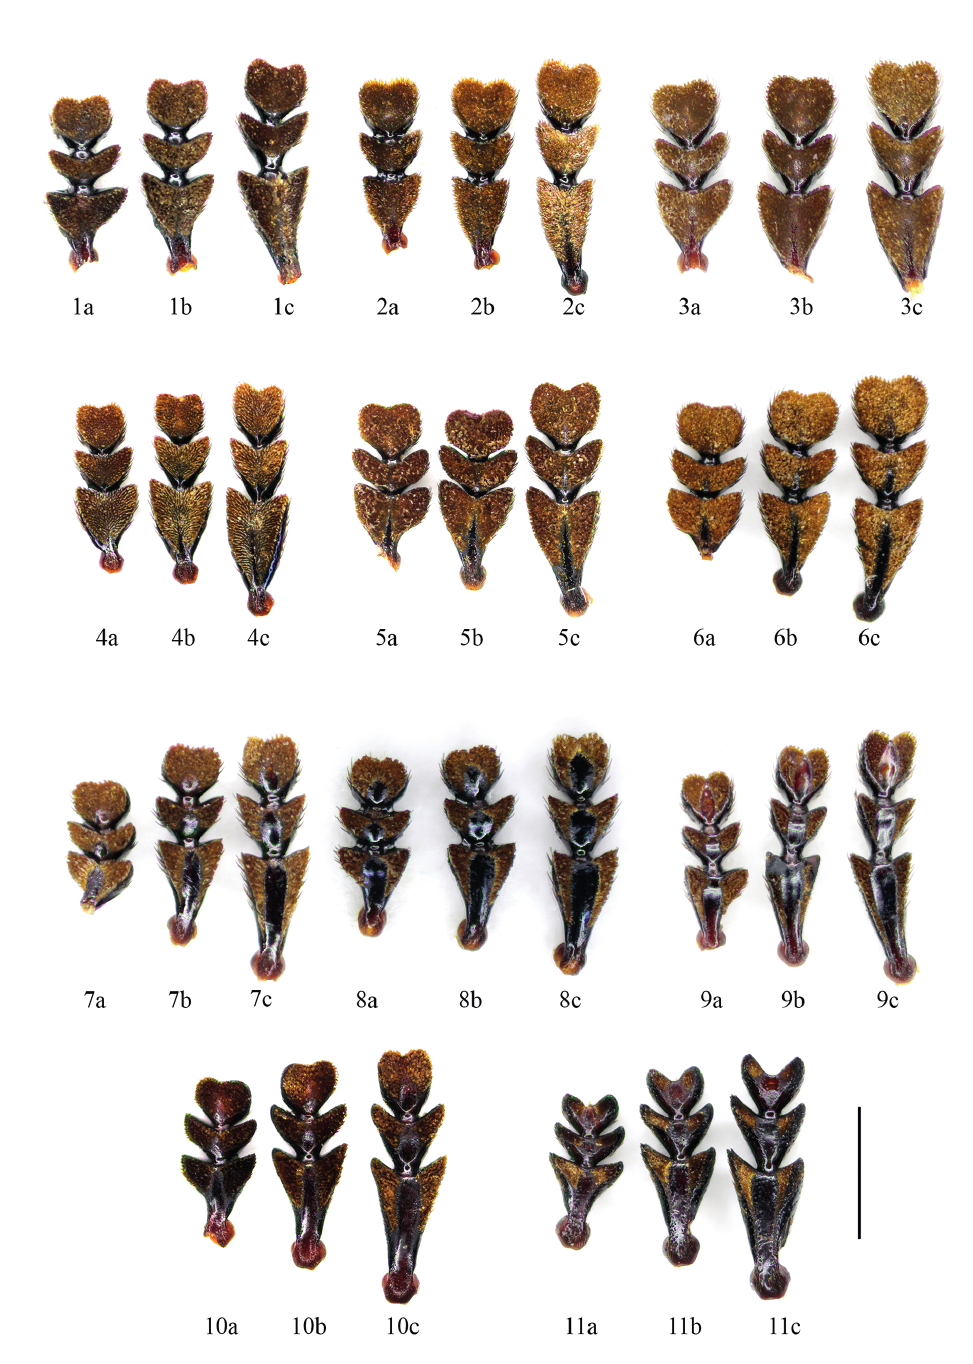
Figs 1–11. Female tarsomeres I–III in ventral view. 1 . Timarcha maroccana (Morocco, Azerzou). 2 . T. scabripennis (Morocco, Souk-el-Khemis des Anjra). 3 . T. prujai (Morocco, Bab Berret). 4 . T. balearica (Spain, Mallorca). 5 . T. tenebricosa (France, Bretagne, Morlaix). 6 . T. nicaeensis (Italy, Alpi Liguri, Margheria dei Boschi). 7 . T. lusitanica (Portugal, Oeiras). 8 . T. goettingensis (France, Versailles). 9 . T. intermedia (Spain, Granada, Motril). 10 . T. pimelioides (Italy, Sicily, Portella Misilbesi). 11 . T. rugosa (Algeria, Biskra). Abbreviations: a = protarsomeres; b = mesotarsomeres; c = metatarsomeres. Scale bar = 2.0